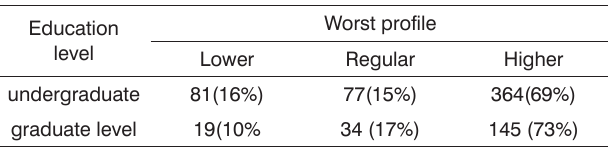
Table 6. Worst profile according to the education level of